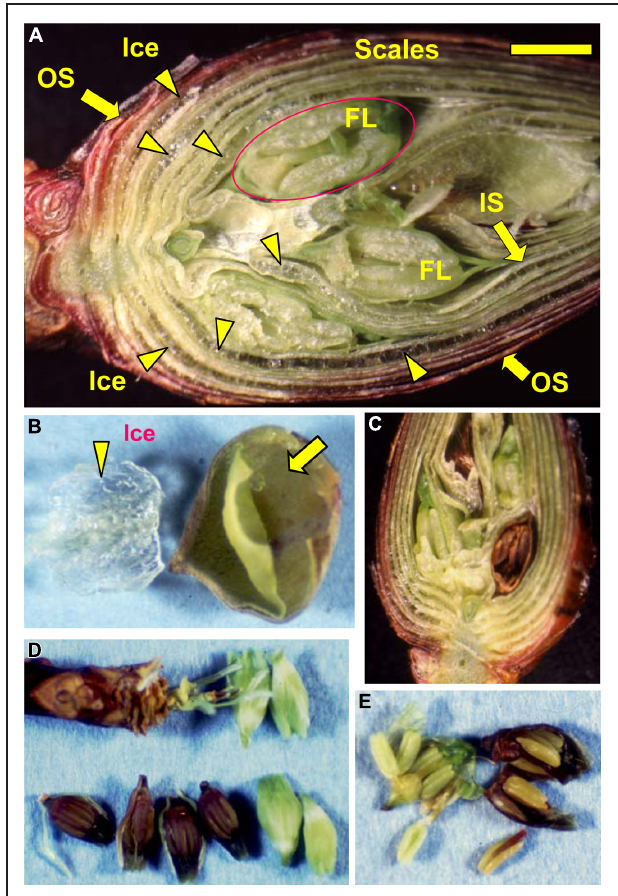
FIGURE 3 | Microscopic observation of a flower bud of R. japonicum (collected in early December) stored at − 15 ◦ C for 3 days following slowing cooling (A). Icicles located within the outer or inner scales are denoted by the arrow heads. OS, outer scale; IS, inner scale; FL, floret. The bar = 2 mm. (B) Accumulated ice was removed from an outer flower bud scale with forceps, a large bag-like cavity that had been formed by the ice formation within the scale was then clearly evident (arrowed). Freezing of supercooled florets (releasing LTE as shown in Figure 1A ) resulted in all or nothing type of injury in the florets which turned brown (C,D) with all the tissues in the floret injured (E) whilst the unfrozen florets remained viable and green (C–E)